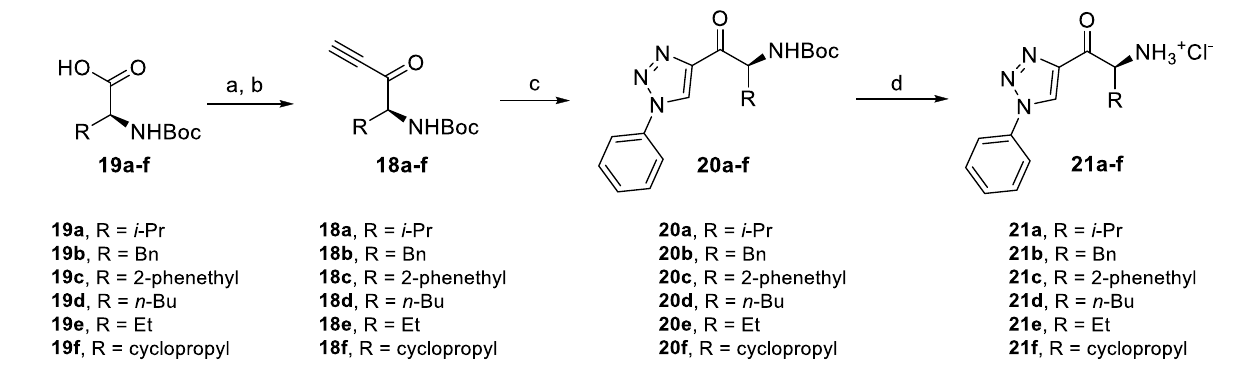
Figure 7. Synthesis of triazole derivatives with variation of the alkyl chain. Reagents and conditions: (a) (i) CDI, DCM, r.t., (ii) N , O -dimethylhydroxylamine hydrochloride, DCM, r.t., 91 – 100%; (b) (i) ethynylmagnesium bromide, THF, -78 °C, (ii) NaHSO 4 , H 2 O, 0 °C, 86 – 95%; (c) phenyl azide, CuSO 4 .5H 2 O, sodium ascorbate, t- BuOH/H 2 O 1:1, r.t., 83 – 94%; and (d) AcCl, MeOH, r.t., 94 – 97%.